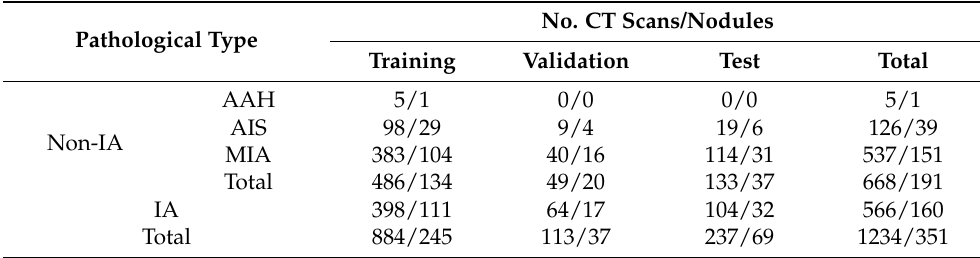
Table 1. Number of CT scans/nodules in training, validation, and test set. Pathological